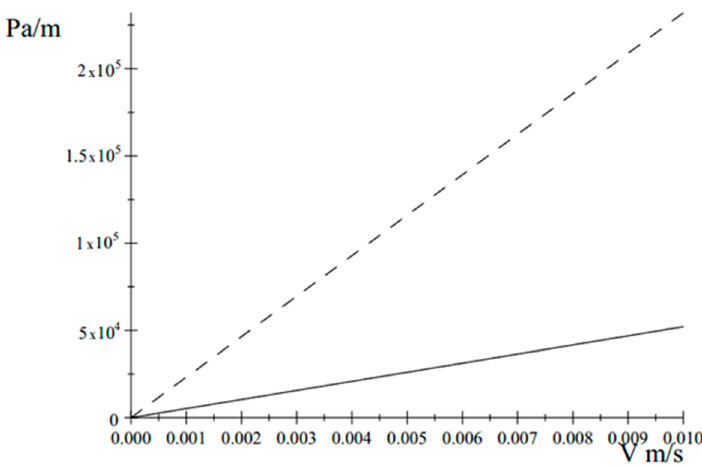
Figure 8. Phase stratification effect. Emulsion (dashed line) and phase separation (solid line) with d p = 0.01 m, ϕ = 0.1, and ε = 0.4.